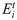
The natural history of the airborne disease infection.We assume that in the natural history of airborne diseases a susceptible individual will pass through a latent period (Eit, 11.6 days) after being exposed, followed by a symptomatic state (IPit, 2.49 days), and will eventually reach an infectious state during which a rash appears (ICit, 18.3 days). Both the fever onset and rash states are considered infectious [26]. Infected individuals will either recover or die (Rit). We assume that in the baseline outbreak scenario, 50% of the patients with a rash will be hospitalized and isolated (IHit), 95% of the rest will be isolated at home (IQit); during the latter period the individual will stay home and not visit any other locations.